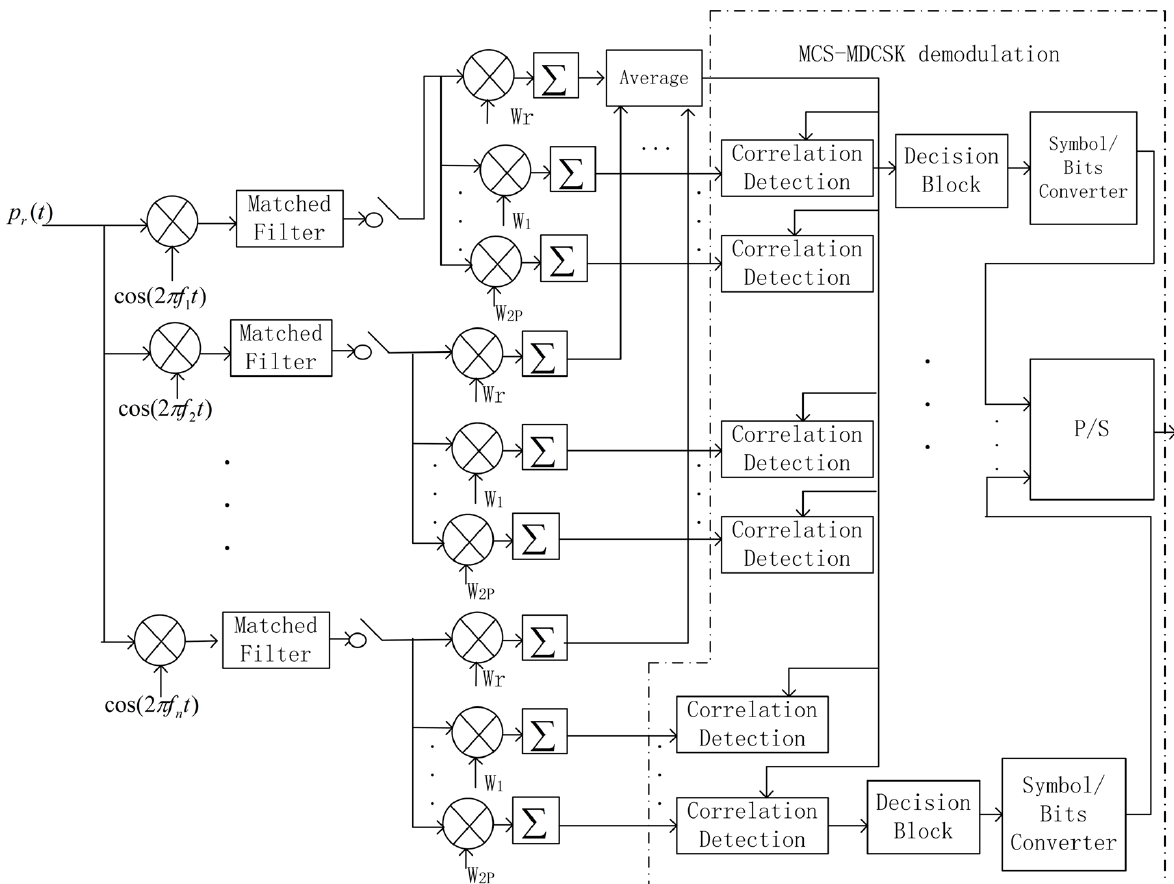
Figure 4. Block diagram of the MC-MDCSK-MCS receiver.